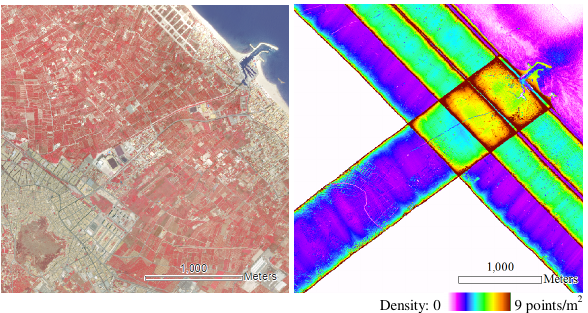
Figure 1. Study area in colour infrared composition (left) and actual density distribution map of LiDAR data